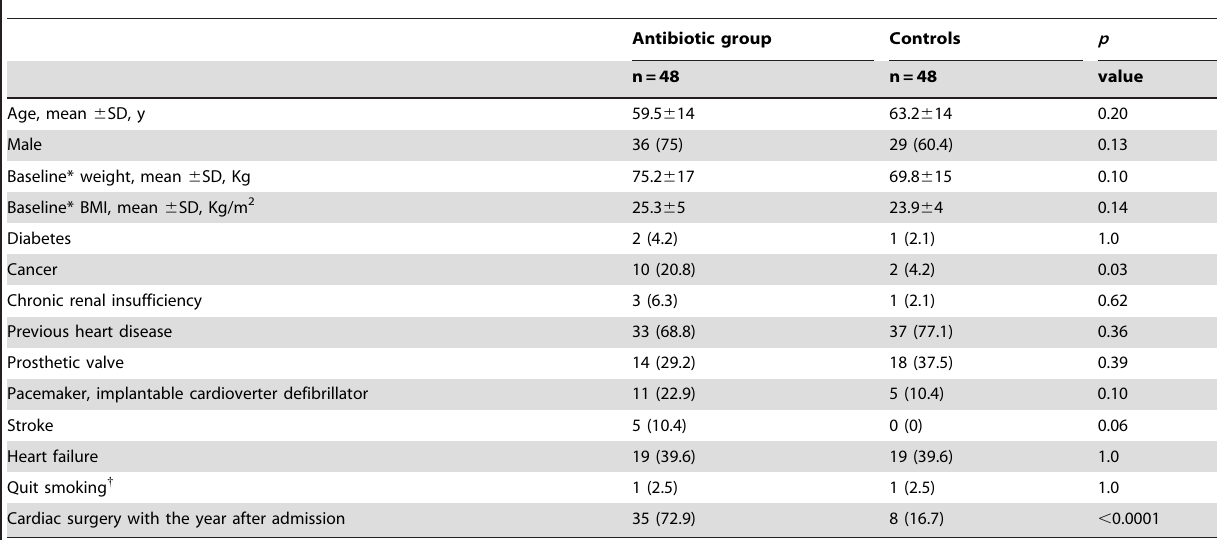
Table 1. Clinical characteristics of patients in the Antibiotic and control